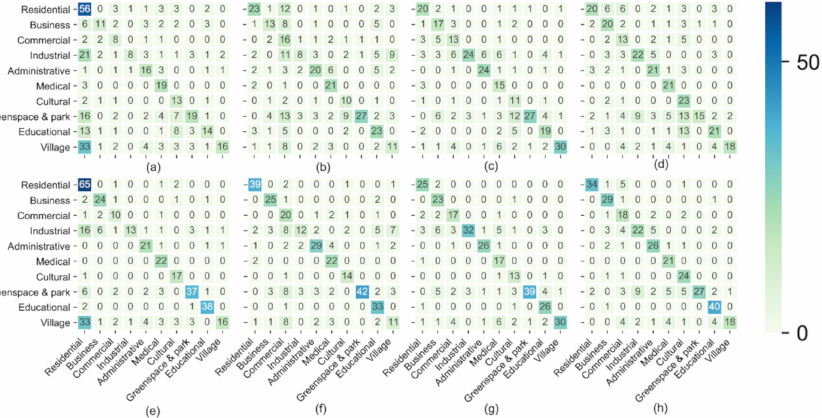
Figure 13. Confusion matrix for accuracy assessment of mapping results of EULUC-AOI in Beijing, 2019. ( a – d ) The confusion matrix before integrating the AOI layers of OSM, OSM and 300 m grid, OSM and 200 m grid, and 100 m grid in turn; ( e – h ) The confusion matrix after integrating AOIs layers of OSM, OSM and 300 m grid, OSM and 200 m grid, and OSM and 100 m grid in turn.